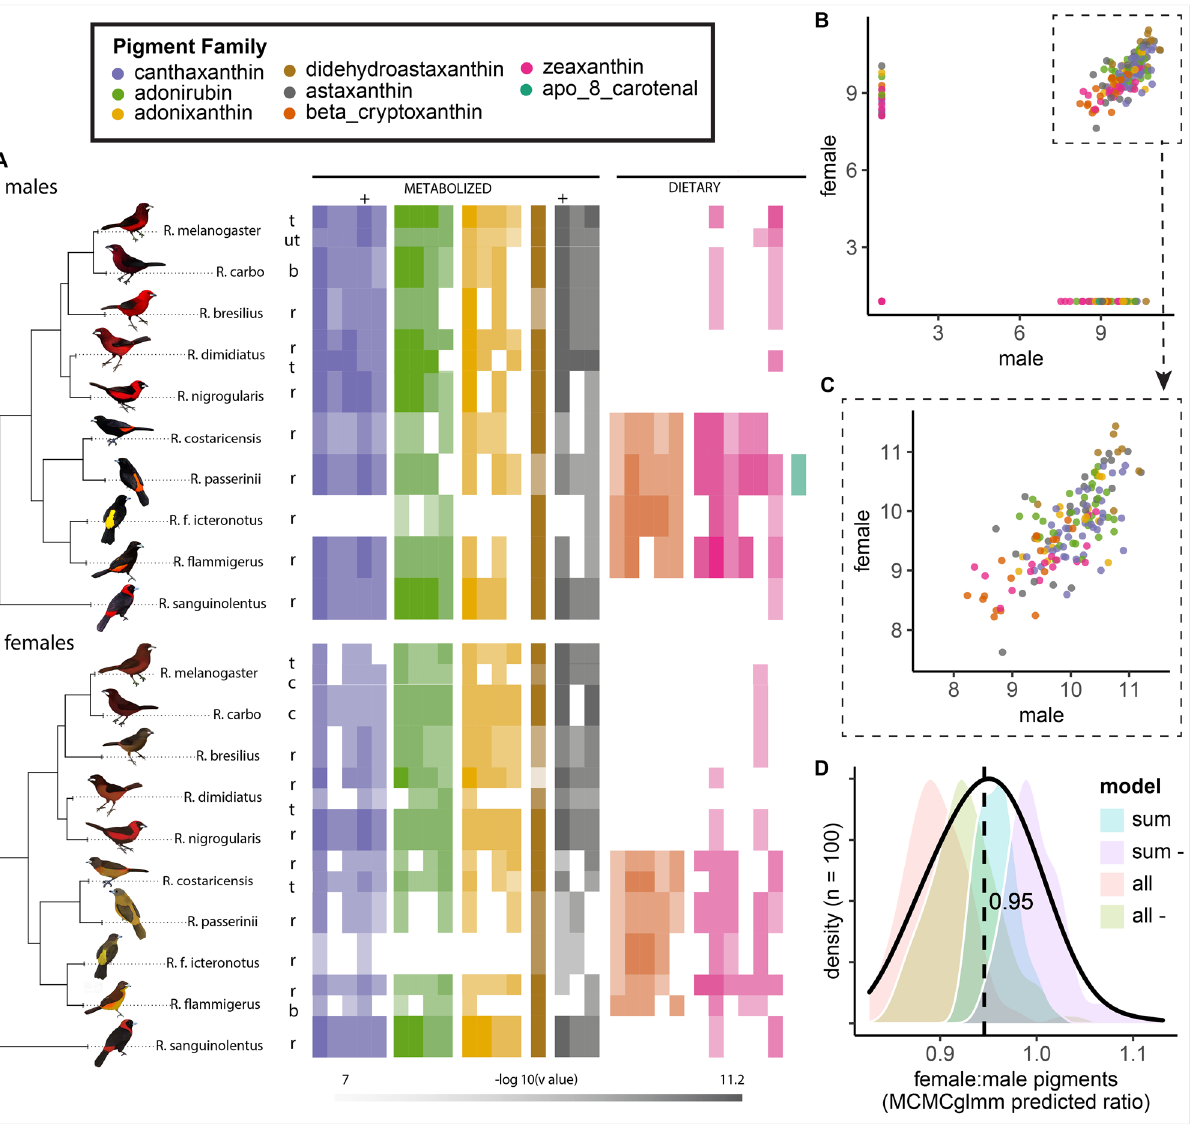
Figure 3. Across species, males and females have significantly correlated carotenoid profiles with a mean female:male ratio of 0.95. ( A ) Relative log-transformed presence of pigments across birds for males (N species = 10, N patches = 12) and females (N species = 10, N patches = 14). Color saturation indicates normalized signal strength of a given pigment molecule within a bird, where pale is least and rich is most. Relative intensity comparison can therefore only be made within each molecule (column). Some comparisons are possible within each family, because response factors of isomers are expected to be similar. Because standards were not available for all molecules, some molecules were identified based on accurate mass, retention time, MS/MS spectra, and the literature (see Table S4). ( B,C ) Male versus female carotenoid pigments; each point represents the signal strength (a proxy for presence and amount) of a given pigment in both a male and female of one species. All values are log-transformed and normalized. Male and female pigment profiles are significantly correlated (MCMCglmm model including pigment family and phylogeny as random effects; for fixed effect male pigment as a predictor of female pigment, posterior mean = 0.55, 95% CI = [0.4434, 0.67], N effective = 1800, p < 0.001, DIC = 1578.2; when pigments were summed by family (Fig. S4, posterior mean = 0.74, 95% CI = [0.52, 0.96], N effective = 1800, p < 0.001, DIC = 377.9 ). C. Zoom in on male versus female carotenoid pigments as shown in B but, for visualization, restricted to points where male and female values were both greater-than-0. ( D ) MCMCglmm model predictions for the ratio between male and female pigment levels; mean ratio was 0.95. Models included were all (all isomers), all- (all isomers minus apo-8-carotenal), sum (summed isomers within pigment families), and sum- (summed isomers within pigment families minus apo-8-carotenal). Abbreviations: t: throat; ut: upper throat; r: rump; b: breast; c: chest. Artwork in male silhouettes credit Gabriel Ugueto; female silhouettes are modified by Allison Shultz from original art by Gabriel